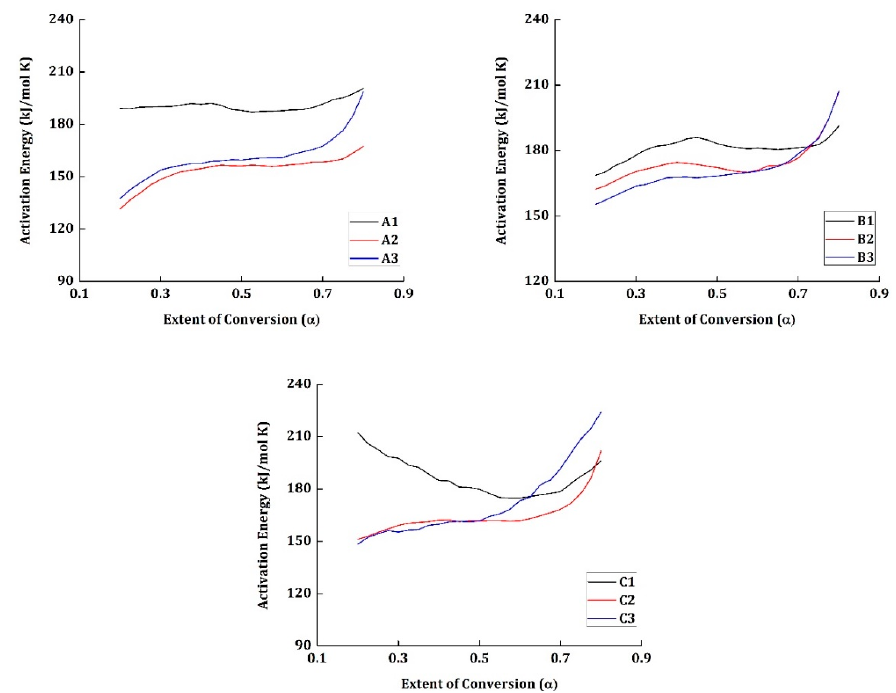
Figure 4. Activation energy vs. extent of conversion for all the materials.